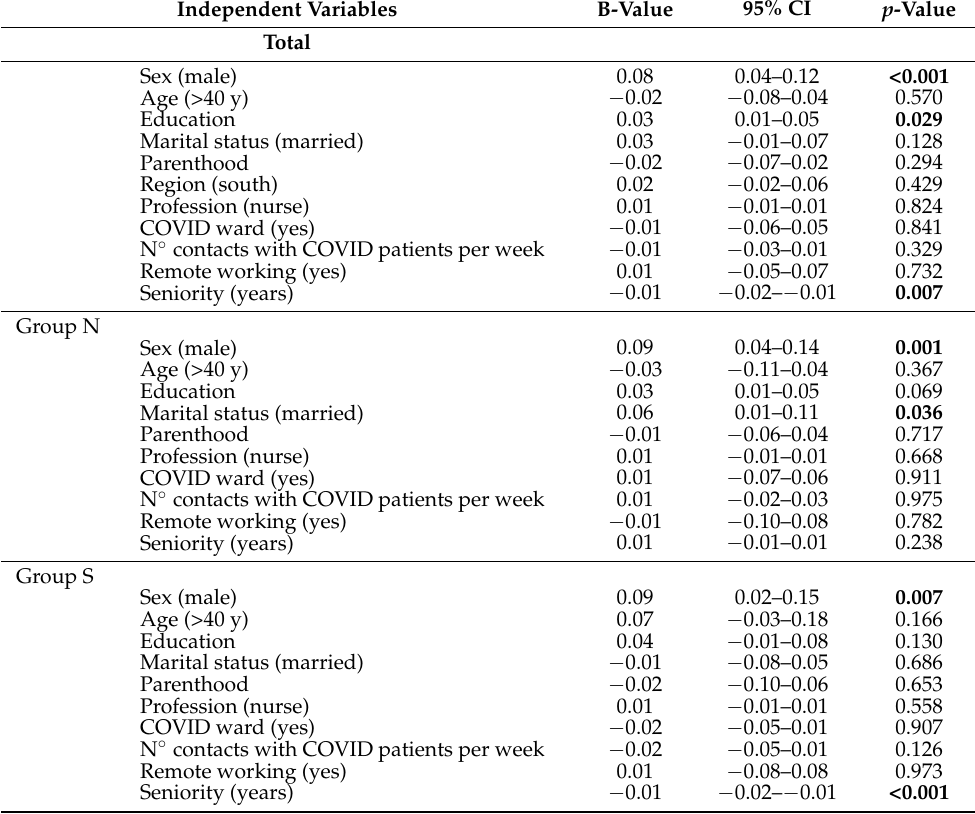
Table 3. Generalized linear model for EQ-5D-Index, assessing quality of life in healthcare workers during the first wave of COVID-19 pandemic ( n =